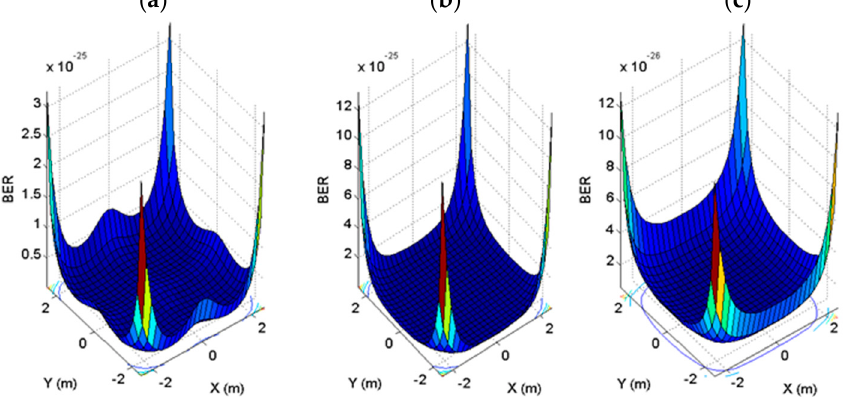
Figure 6. BER ∅ 1/2 = 30 ◦ ( a ) the 4 arrays model, ( b ) the 9 arrays model, and ( c ) the 16 arrays model.